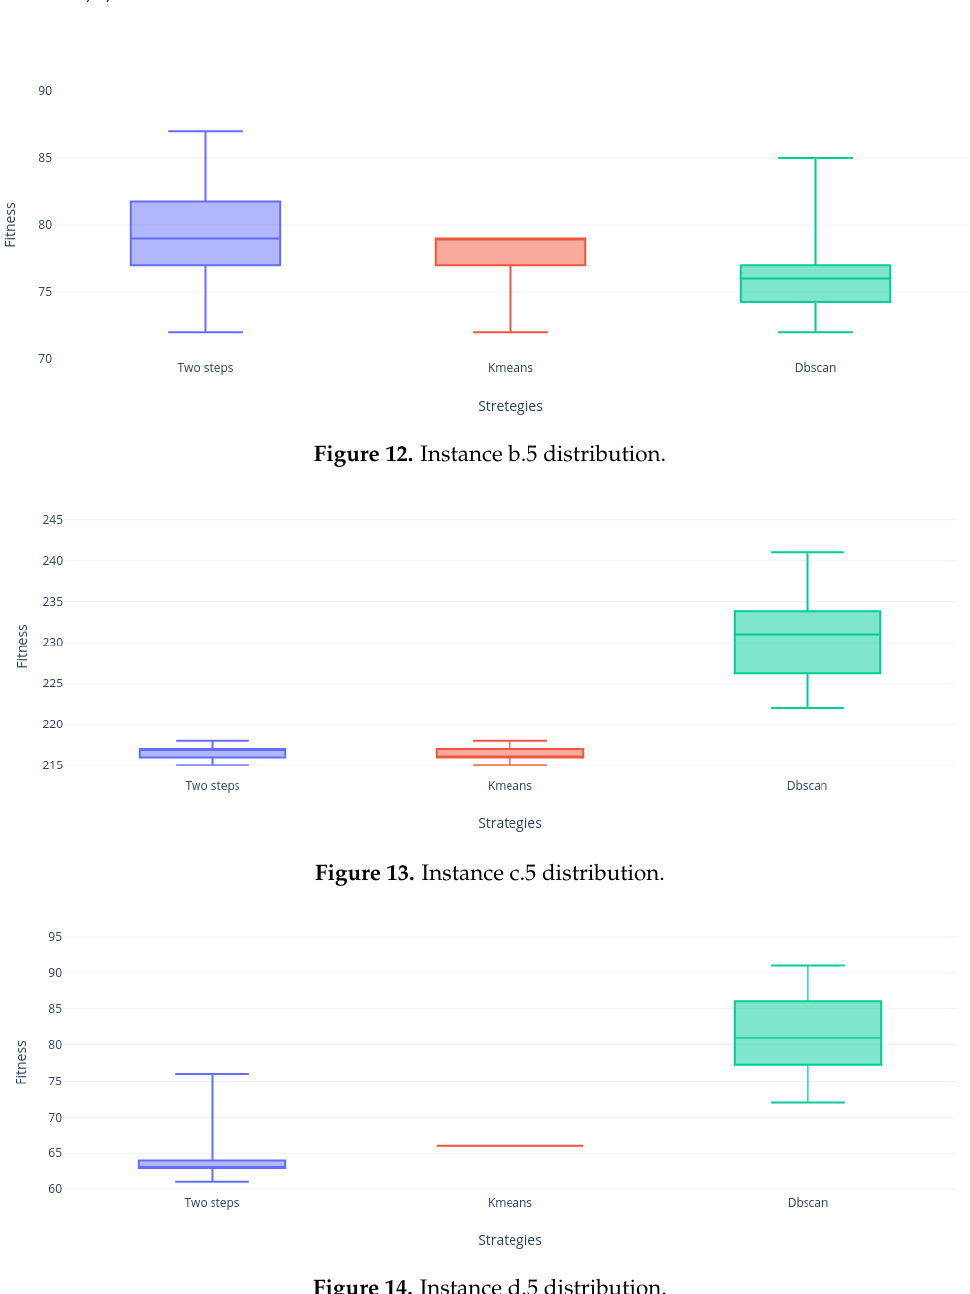
Figure 14. Instance d.5 distribution.